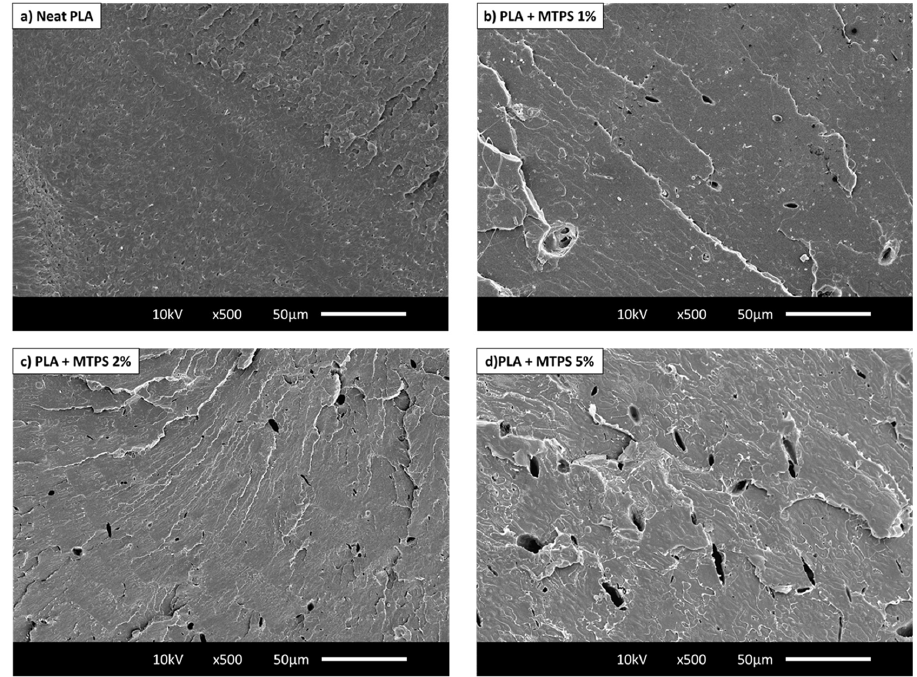
Figure 6. SEM images of the blends after selective extraction of MTPS phase ( a ) PLA, ( b ) PLA + 1% MTPS, ( c ) PLA + 2% MTPS, ( d ) PLA + 5% MTPS.